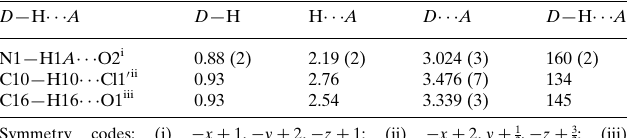
Hydrogen-bond geometry (A˚ , (cid:2)